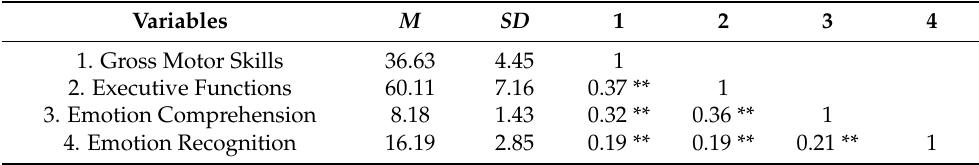
Table 1. Descriptive Statistics and Correlations ( n =